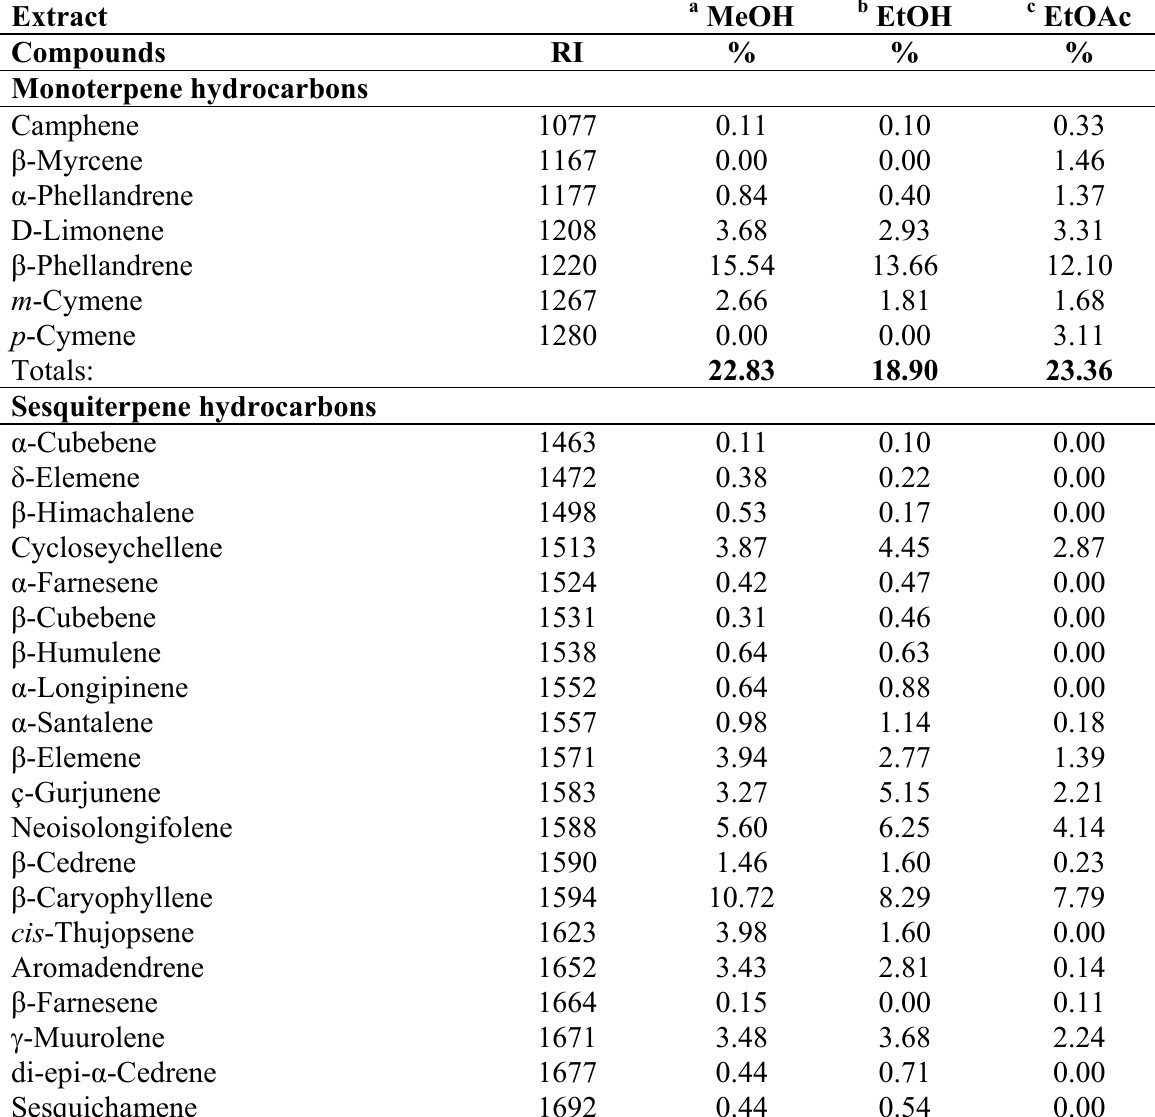
Table 1. Chemical composition of P. cordaeana